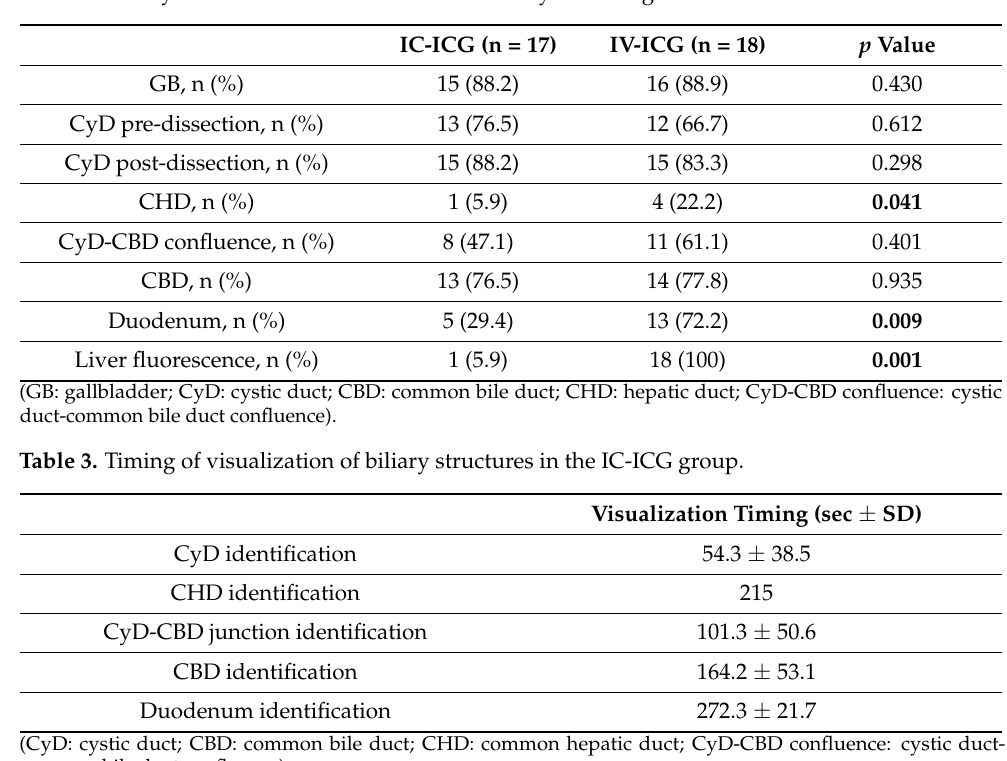
Table 2. Ability of ICG to delineate bile duct anatomy according to the administration method.